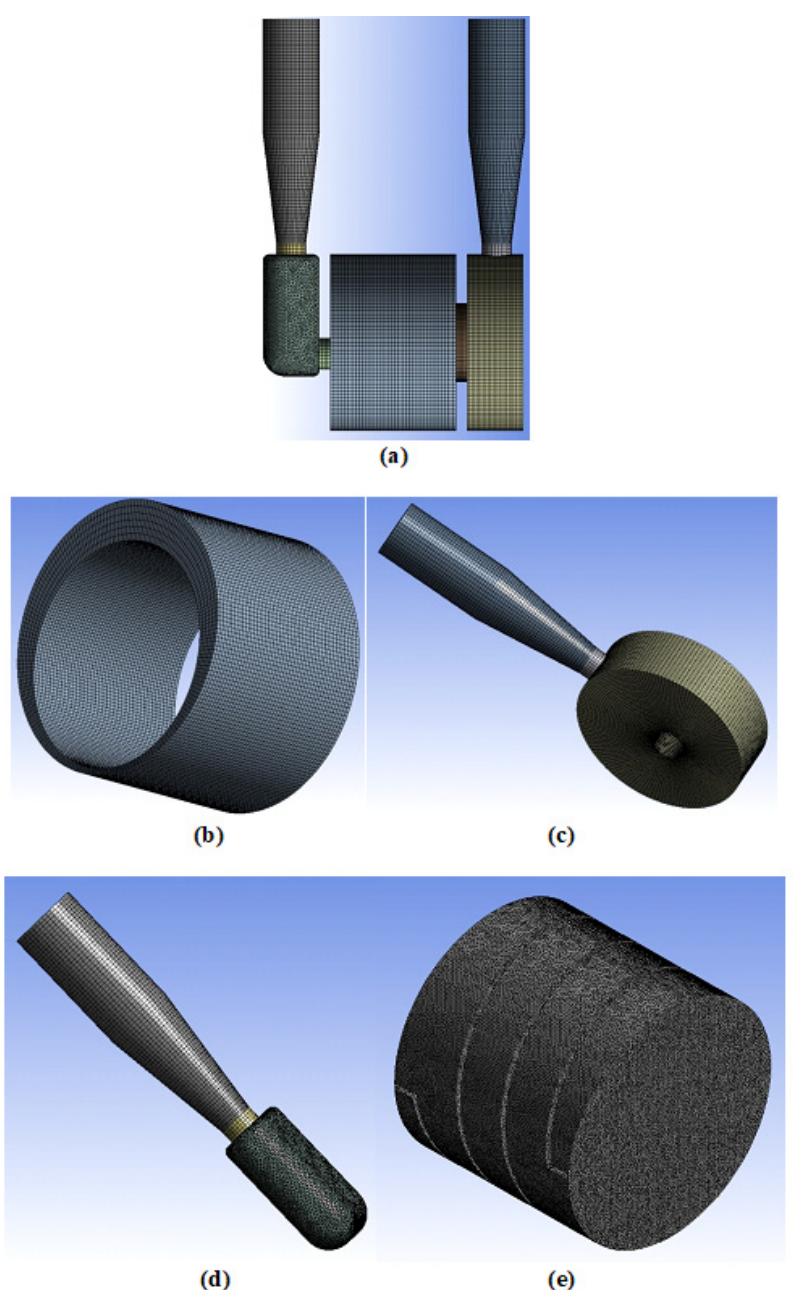
Figure 7. Computational mesh of ( a ) whole pump ( b ) casing ( c ) discharge chamber with water pipe ( d ) suction chamber with water pipe and ( e ) rotor volume.